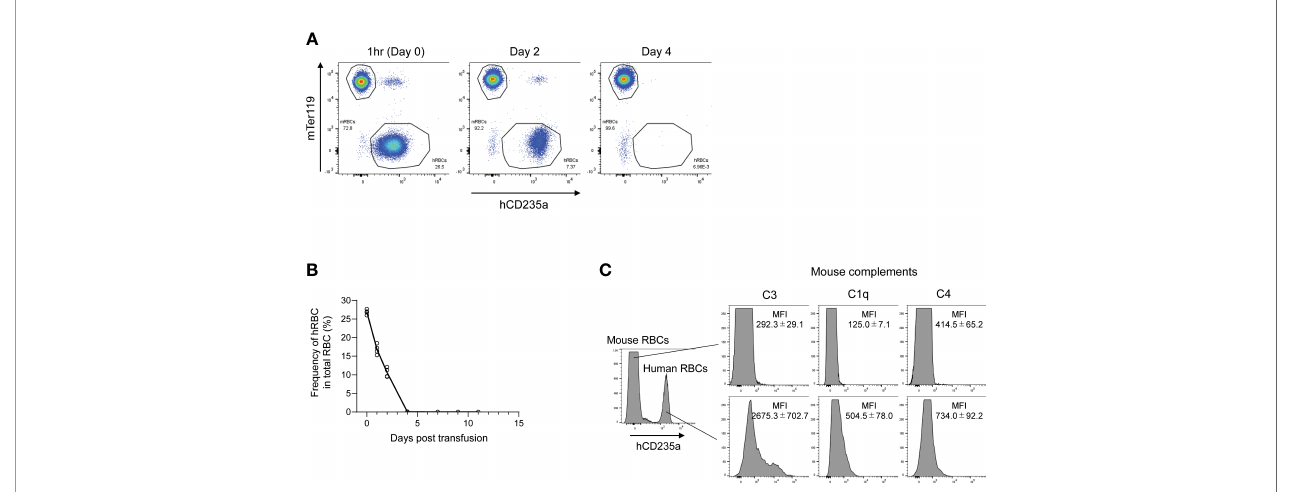
FIGURE 1 | The fate of hRBCs in NOG mice. (A) PB was collected from NOG mice at 1 h, 2 days, and 4 days after hRBC transfusion. Human and mouse RBCs were distinguished based on hCD235a (glycophorin A) and Ter119 expression. A representative FACS plot is shown. (B) Kinetics of transfused hRBCs in NOG mice. PB was collected at the indicated time points, and the presence of hRBCs was assessed using fl ow cytometry. The value on day 0 represents the frequency of hRBCs relative to total RBCs at 1 h after transfusion. Each dot represents a value from each mouse, and the line indicates the time course of the means. (C) Deposition of murine C3 on the surfaces of transfused hRBCs. PB was collected from hRBC-transfused NOG mice at 3 h post-transfusion, stained with anti- human CD235a and anti-mouse C3, C1q, or C4 antibodies, and analyzed using fl ow cytometry. The upper histogram represents mouse (hCD235a - ) RBCs; human (hCD235a + ) RBCs are shown in the lower